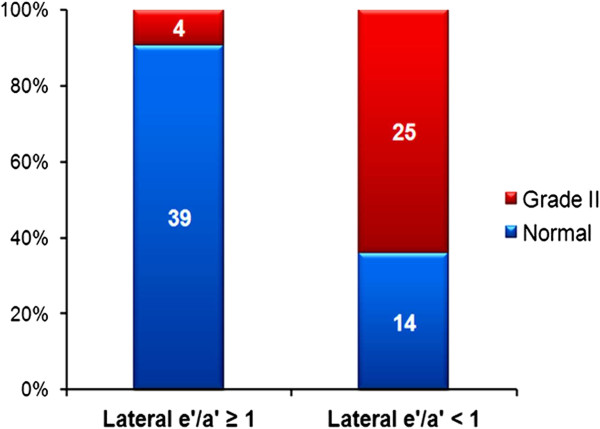
Distribution of normal and grade II diastolic dysfunction according to lateral tissue Doppler imaging patterns.